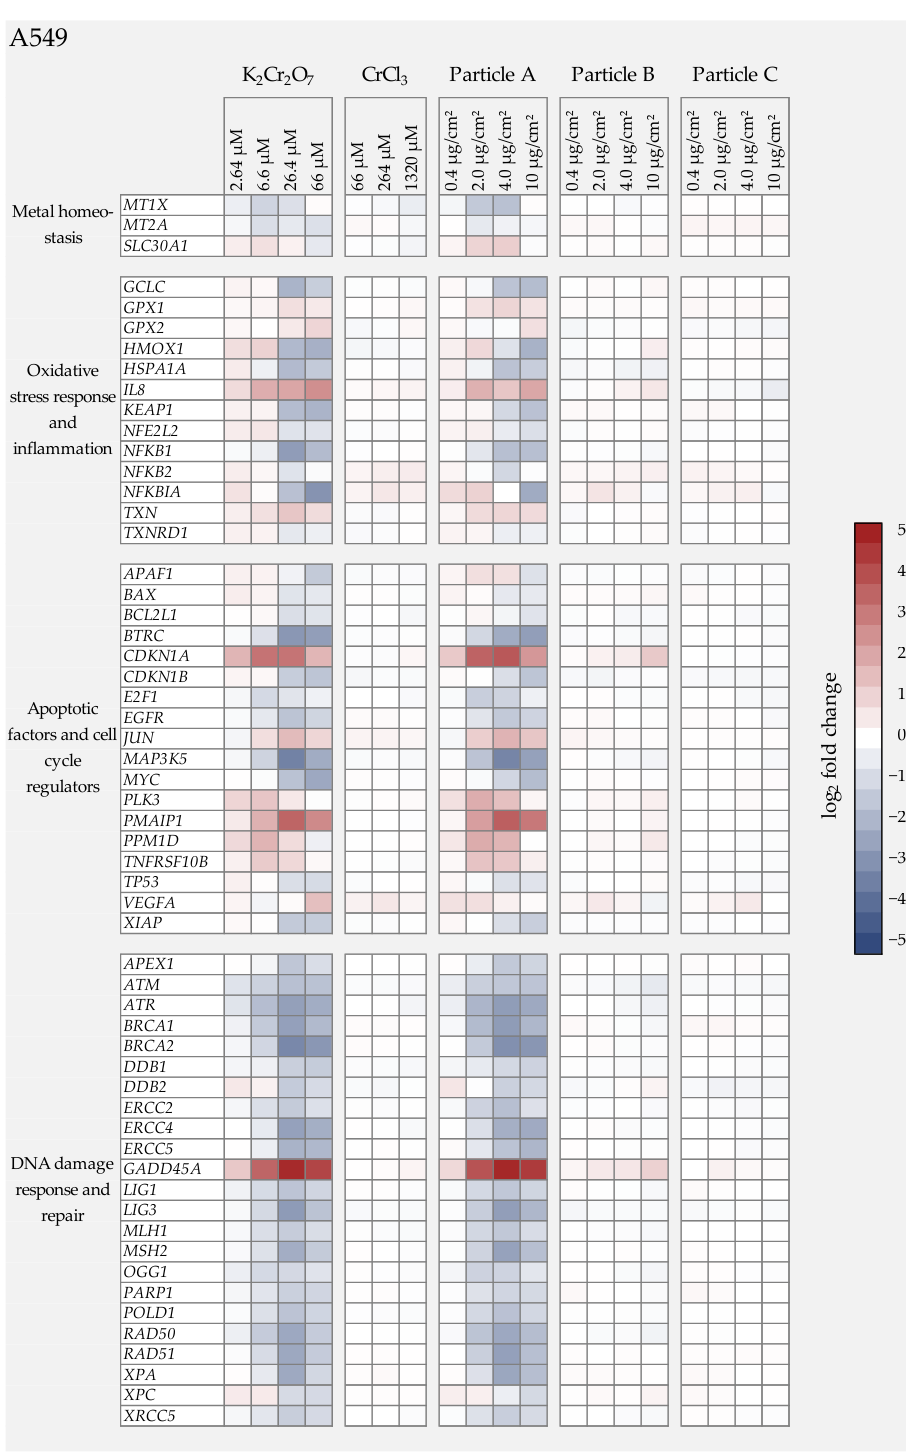
Figure 4. Overview of the impact of K 2 Cr 2 O 7 , CrCl 3 , or three different Cr(III) oxide particles on human lung epithelial cells (A549) using a high-throughput RT-qPCR approach with a custom- designed gene set. The genes under investigation have been clustered into groups associated with metal homeostasis, oxidative stress response, inflammation, apoptosis, and cell cycle regulation as well as DNA damage response and repair. A549 cells were treated with the respective chromium compound for 24 h. Displayed are the log 2 fold changes of relative gene expression as a heatmap. Red colors indicate an enhanced expression, and blue colors indicate a down-regulation. The mean values of at least three independently conducted experiments are shown.